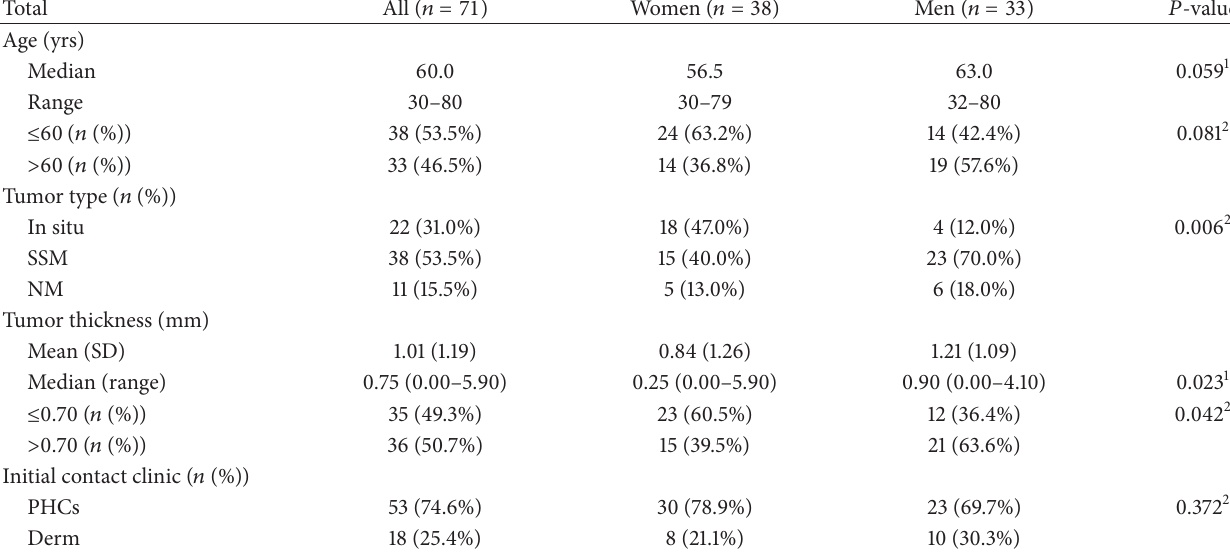
Table 1: Characteristics of included participants: gender related to age, tumor type, tumor thickness, and initial contact